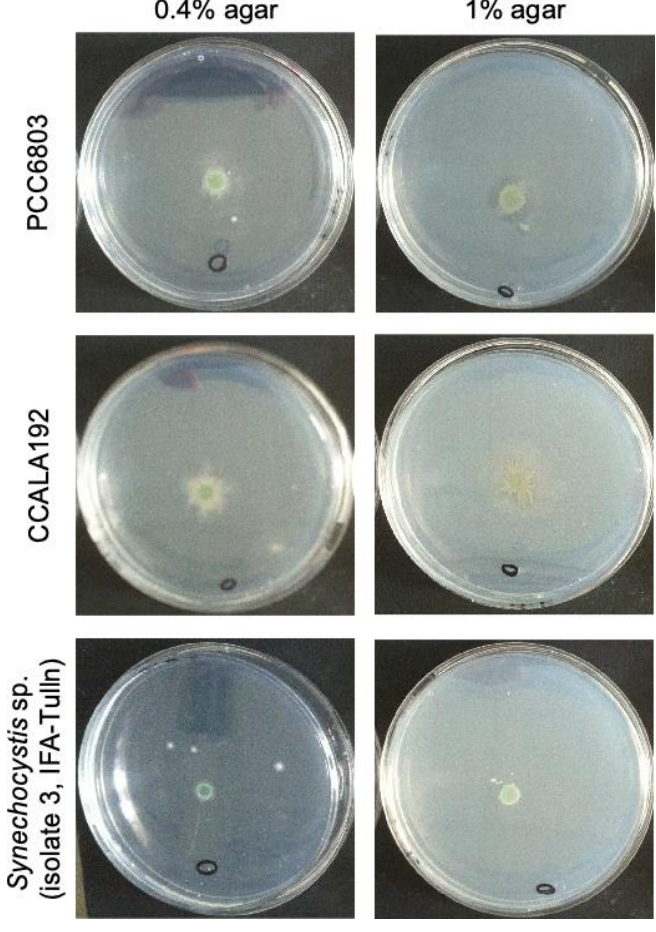
Figure 7. Results of the phototaxis experiment with cultures of PCC6803 ( top ), CCALA192 ( middle ) and Synechocystis sp. IFA-3 ( bottom ) on agar plates with 0.4% ( left ) and 1% agar ( right ). Circle: spot where glucose was applied.